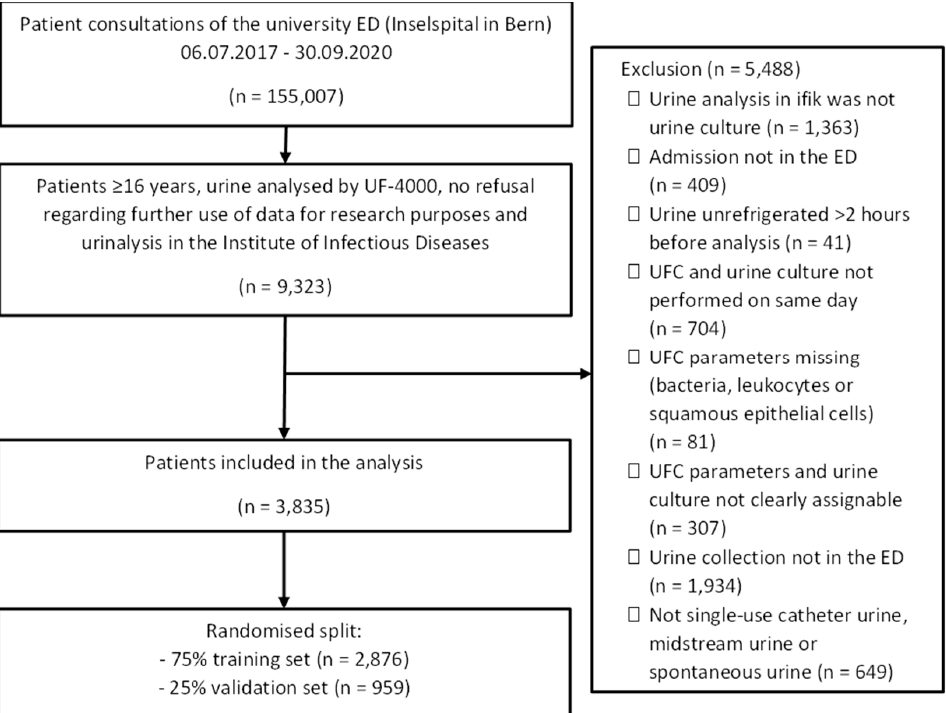
Figure 1. Flowchart of the study.